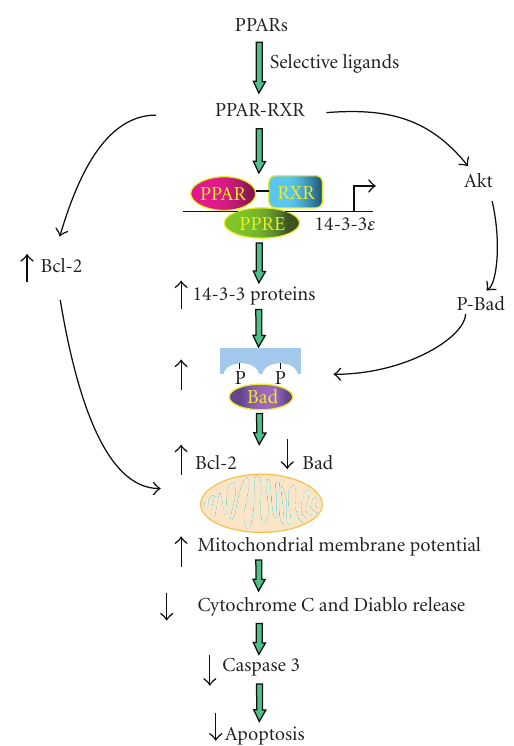
Figure 1: Schematic illustration of proposed signaling pathway by which all three PPAR isoforms exert anti-apoptotic actions via 14- 3-3 ε